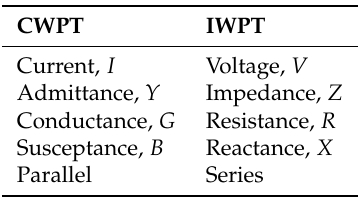
Table 5. Dual quantities between capacitive wireless power transfer (CWPT) and inductive wireless power transfer (IWPT).